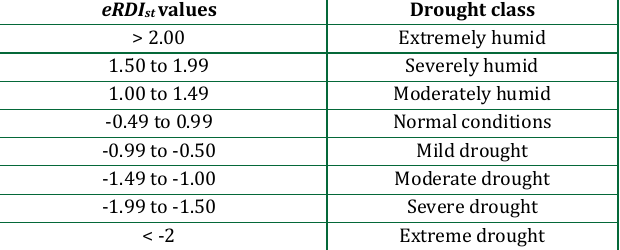
Table 1: Drought characterisation (severity) based on eRDIst values (adopted from (Tigkas et al., 2017) for this study)